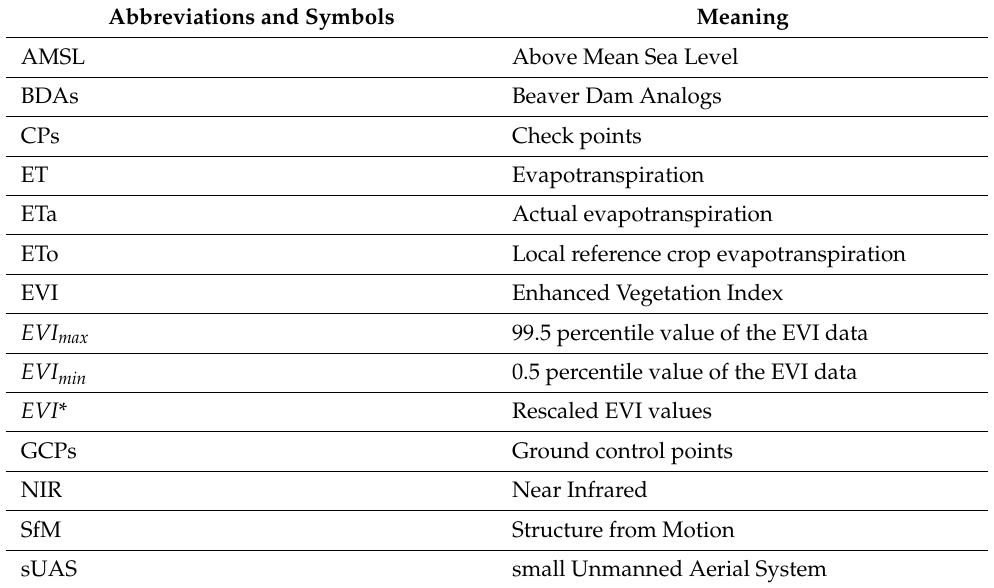
Table 1. Abbreviations and symbols.